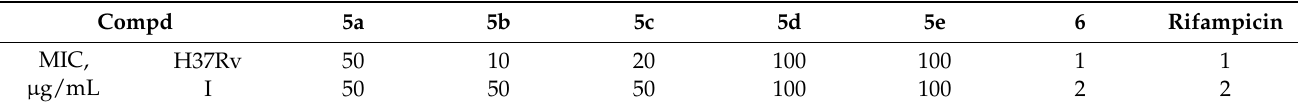
Table 2. In vitro antitubercular activity (MIC) of 2-amino-8-oxa-1,5-diazaspiro[4.5]dec-1-en-5-ium benzoates and chloride ( 5a – e , 6 ), µ g/mL * on DS (H37Rv) and MDR (I) strains of MTB. Compd 5a 5b MIC, H37Rv µ g/mL * In the upper line of MIC values, the activity on the DS of MTB strains (H37Rv) is shown; in the lower–on the wild MDR strains (I), isolated from the patient, resistant to rifampicin and